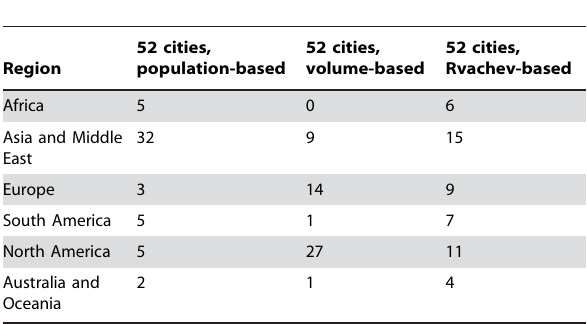
Table 1. Distribution of sampled cities across